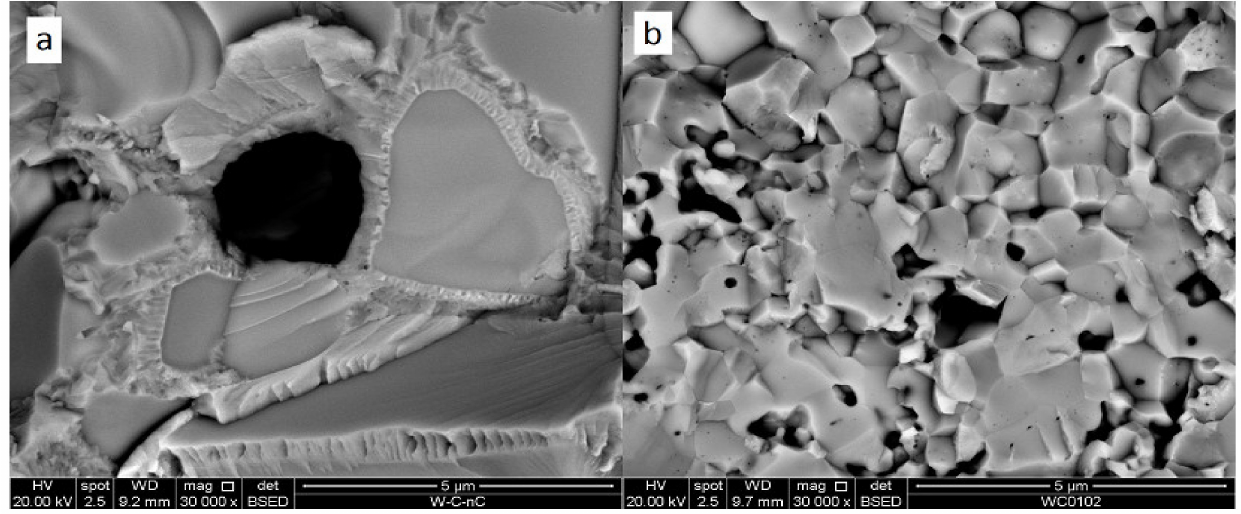
Figure 7. Fracture surfaces of W + 1.3% C materials sintered at 1850 ◦ C ( a ) and 1300 ◦ C ( b ) (Samples #1 and #4